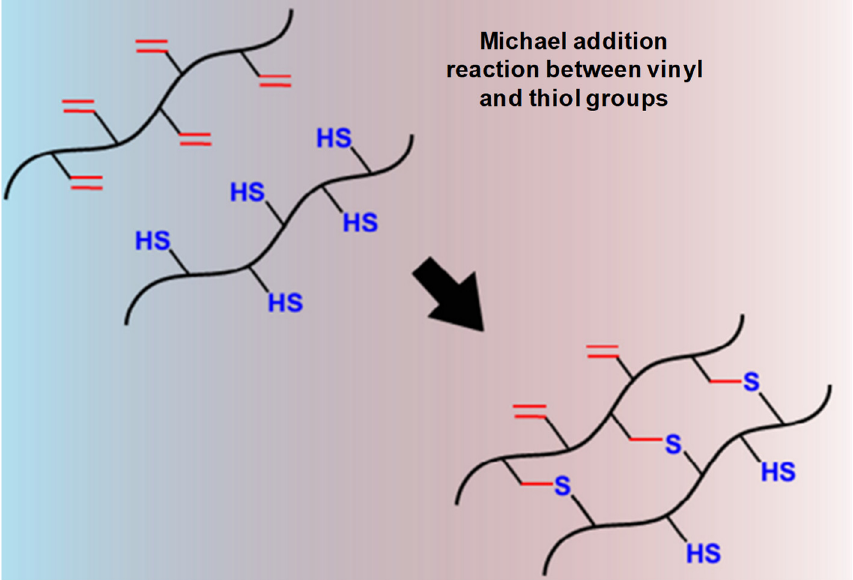
Figure 7. Schematic thiol-based Michael reaction between vinyl and thiol groups mechanism. Adapted with permission from ref. [8]. Copyright © 2015 European Polymer Journal .